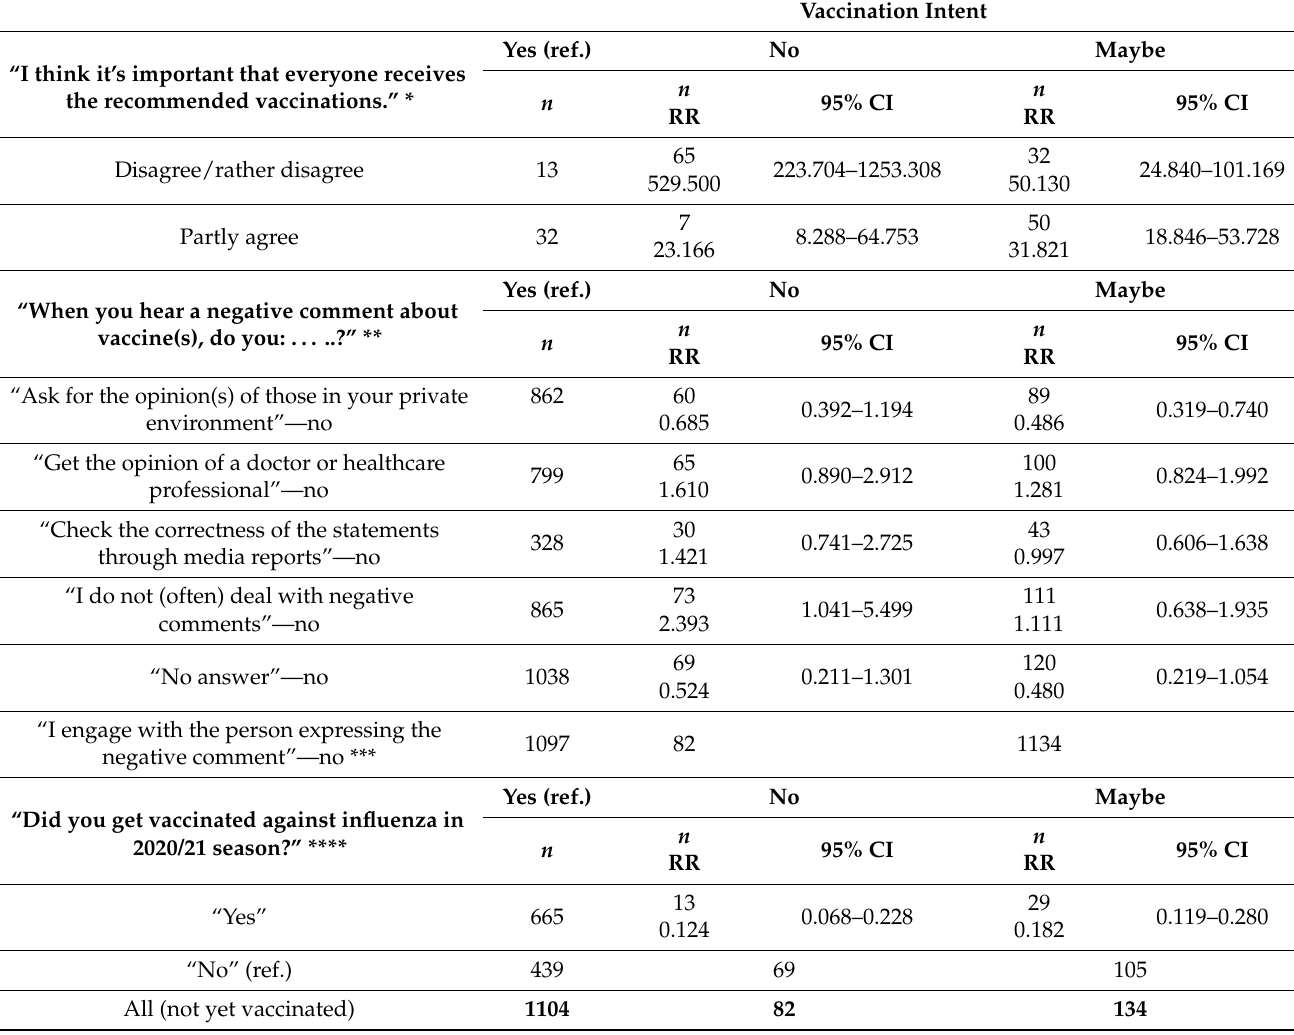
Table 3. Multinomial logistic regression of attitudes towards vaccinations associated with intent to receive a COVID-19 vaccine.